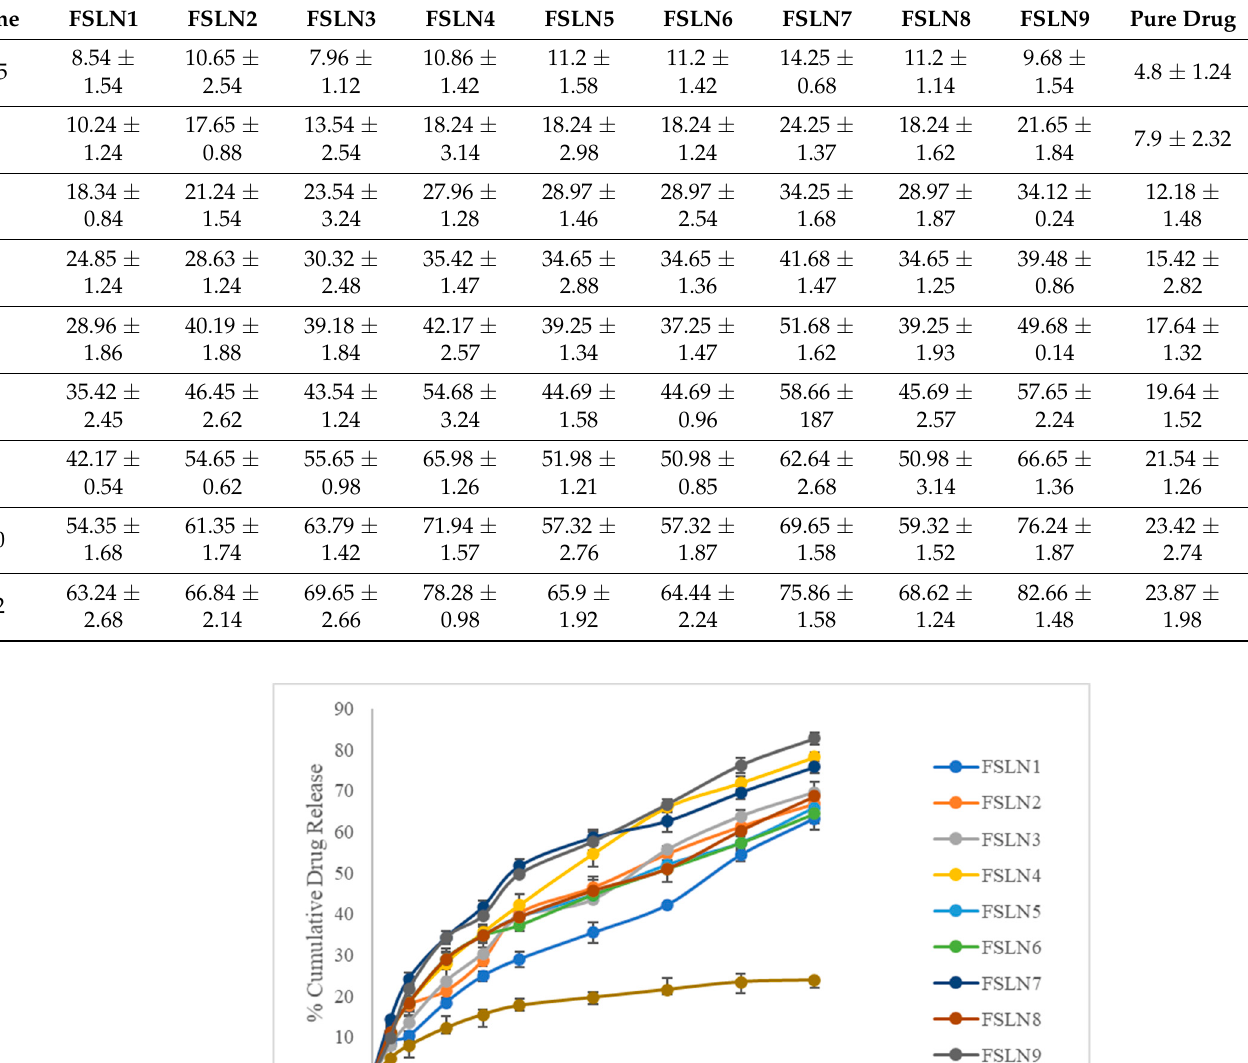
Table 3. In-vitro drug release data of all formulations (Data represents mean of six determinations ± standard deviation).